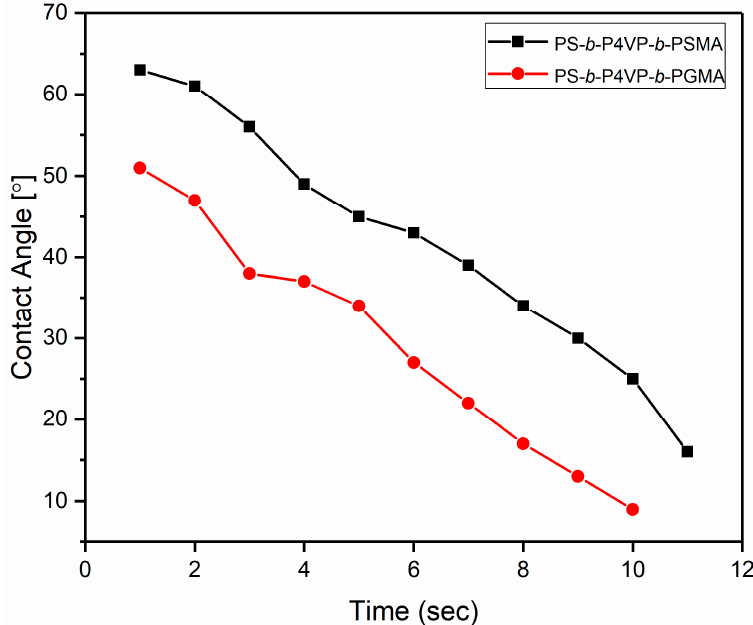
Figure 7. Dynamic contact angle measurements of water droplets (2 μ L each) onto the PS 71 - b -P4VP 26 - b -PSMA 3145 ( black squares ) and PS 71 - b -P4VP 26 - b -PGMA 3145 ( red circles )